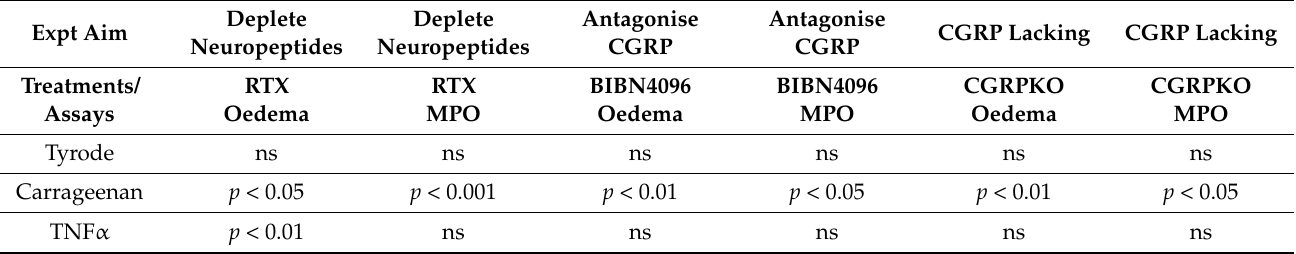
Table 1. Summary data to show the effect of modulating Calcitonin gene-related peptide, CGRP, levels on oedema and neutrophil accumulation (Myeloperoxidase, MPO) in response to carrageenan and tumour necrosis factor alpha, TNF α . Three models that enable modulation of CGRP activity were used. Sensory nerves were depleted with resiniferatoxin (RTX 0.3 mg/kg, s.c. for 4 days), left hand columns. CGRP responses were antagonised with CGRP receptor antagonist, BIBN4096BS (3 mg/kg i.p. given at two timepoints, see methods), middle columns. WT and α CGRP KO mice were also investigated, right-hand columns. For all experiments carrageenan, TNF α and Tyrode (control) were investigated over 4 h. Results are shown as mean ± SEM ( n = 5–10). Two-way ANOVA with Bonferroni’s post hoc test. Significance is shown for agent compared with relevant control; ns is